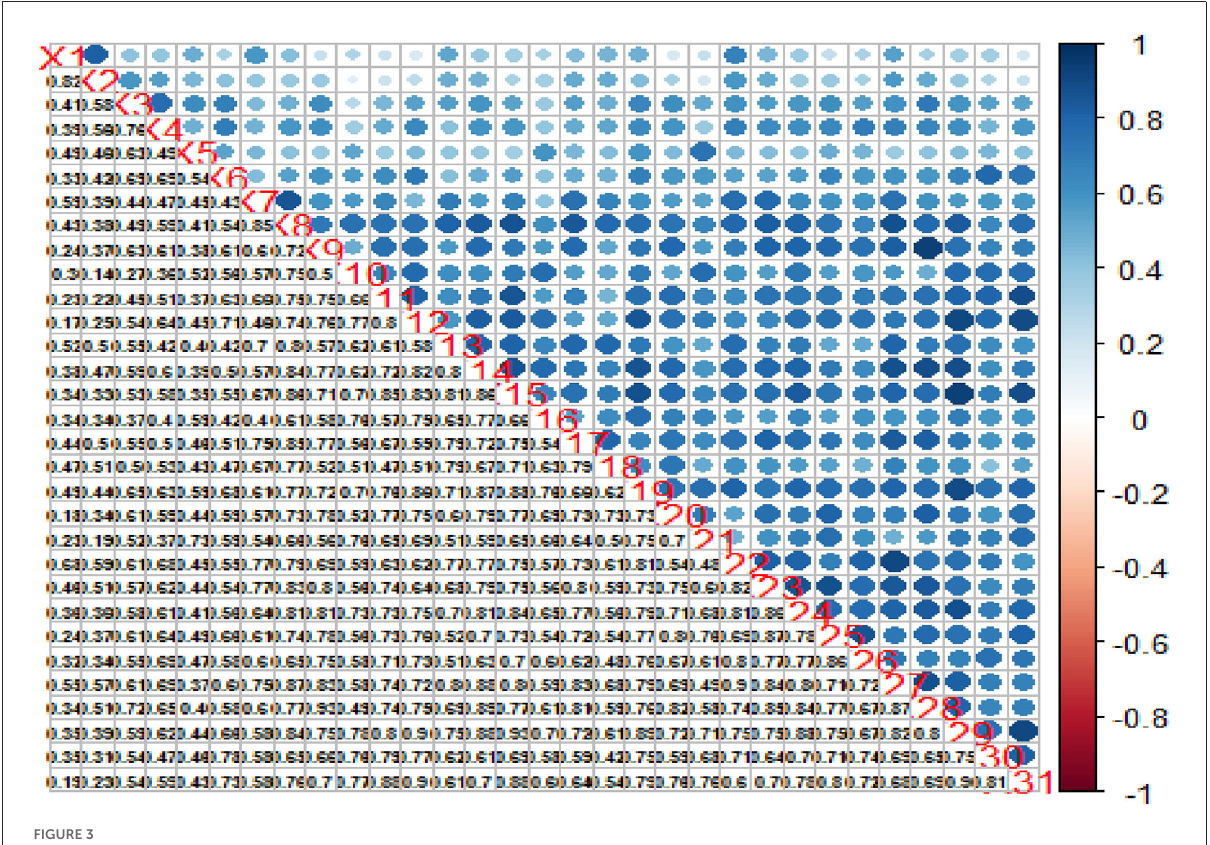
FIGURE3 Variable correlation